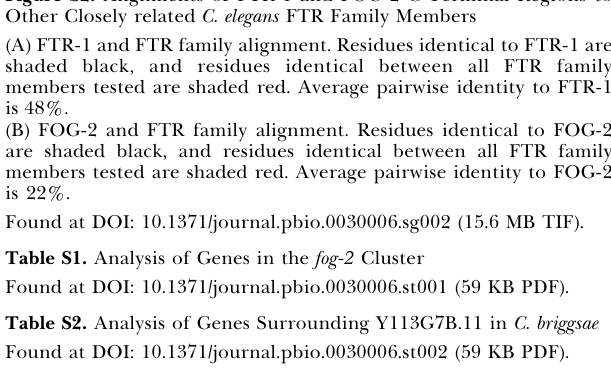
Figure S2. Alignments of FTR-1 and FOG-2 C-Terminal Regions to Other Closely related C. elegans FTR Family Members (A) FTR-1 and FTR family alignment. Residues identical to FTR-1 are shaded black, and residues identical between all FTR family members tested are shaded red. Average pairwise identity to FTR-1 is 48%. (B) FOG-2 and FTR family alignment. Residues identical to FOG-2 are shaded black, and residues identical between all FTR family members tested are shaded red. Average pairwise identity to FOG-2 is 22%. Table S1. Analysis of Genes in the fog-2 Cluster Table S2. Analysis of Genes Surrounding Y113G7B.11 in C. briggsae Found at DOI: 10.1371/journal.pbio.0030006.st002 (59 KB